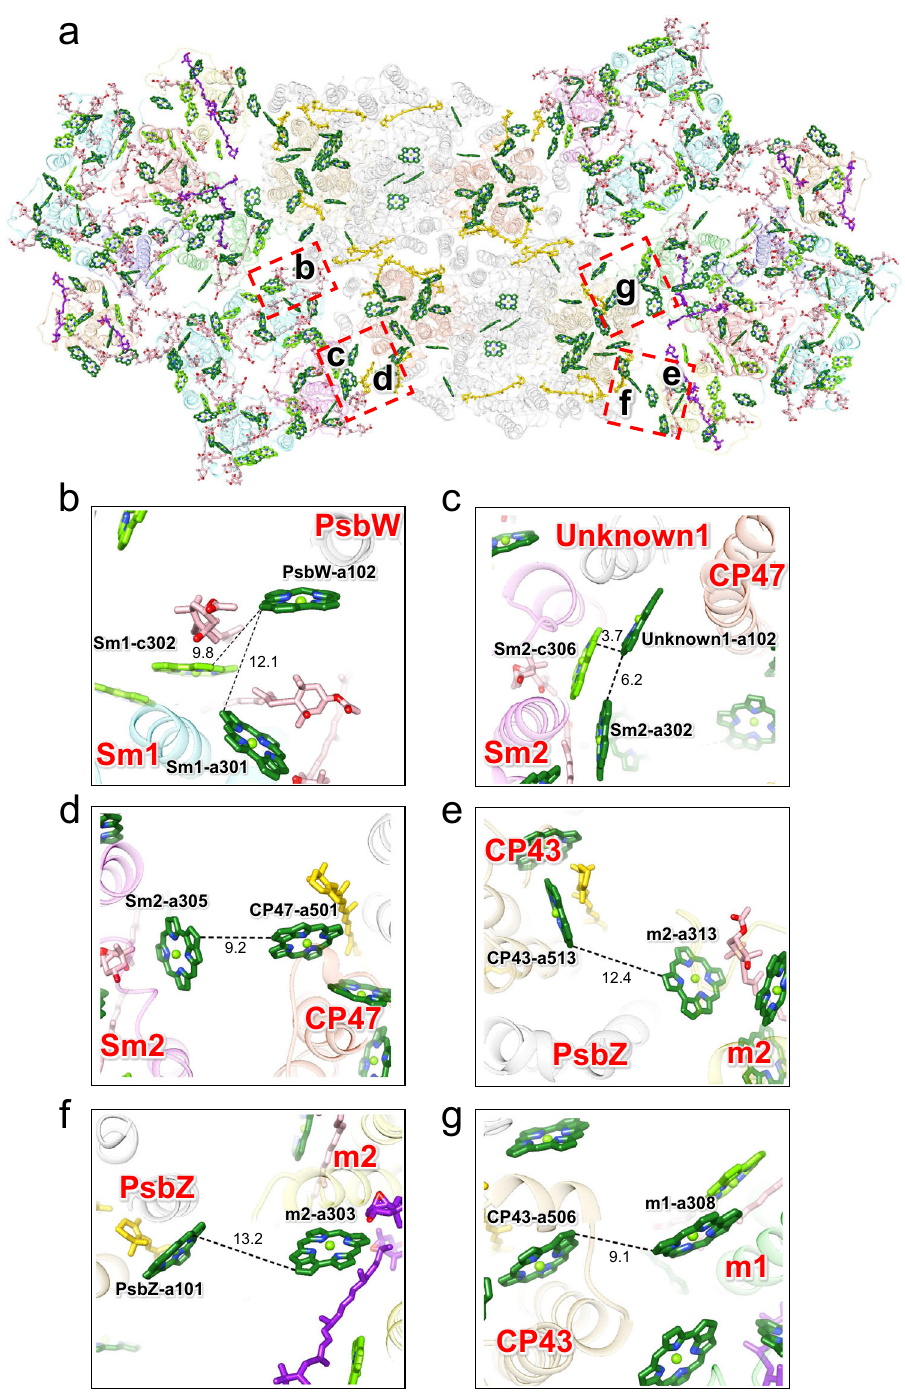
Fig. 6 Excitation-energy-transfer pathways from FCPII to PSII. a Pigment-pigment interactions in the PSII-FCPII. The structure is viewed from the stromal side. Colors of the FCPII subunits are the same as in Fig. 1. CP47 and CP43 are colored “ orange red ” and “ goldenrod ” , respectively. The pigments of Chl a , Chl c , Fx, Ddx, and β -carotene are colored “ forest green ” , “ bright green ” , “ pink ” , “ purple ” , and “ gold ” , respectively. Only rings of the Chls are depicted. Red squared areas are enlarged in panels b – g , in order to show energy-transfer pathways from FCPII to PSII. Interactions are indicated by dashed lines and numbers are distances in Å. b Interactions between Sm1 and PsbW from the adjacent PSII-FCPII unit viewed from the stromal side. c Interactions between Sm2 and CP47/Unknown1 viewed from the stromal side. d Interactions between Sm2 and CP47 viewed from the lumenal side. e Interactions between m2 and CP43/PsbZ viewed from the stromal side. f Interactions between m2 and PsbZ viewed from the lumenal side. g Interactions between m1 and CP43 viewed from the stromal